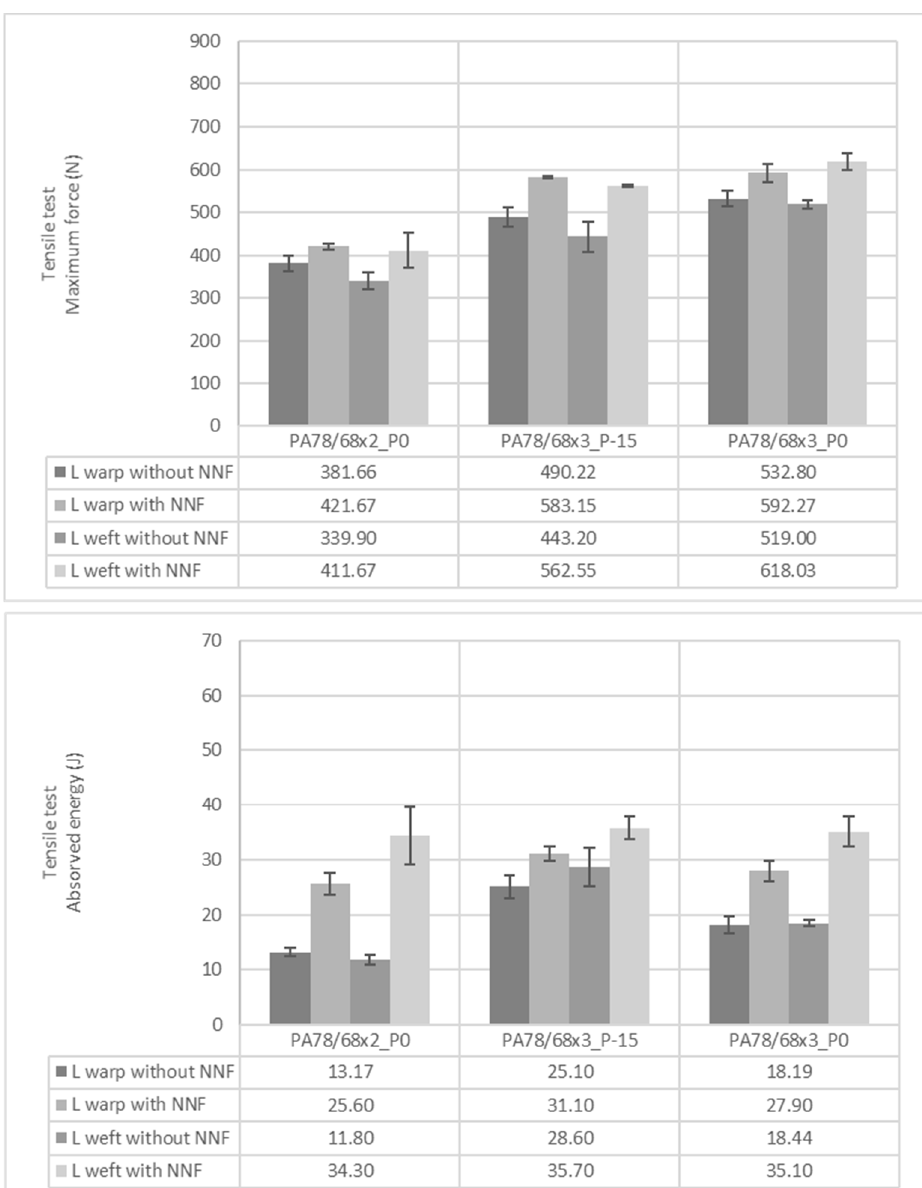
Figure 6. Maximum force and absorbed energy of knits with L pattern obtained on tensile tests.